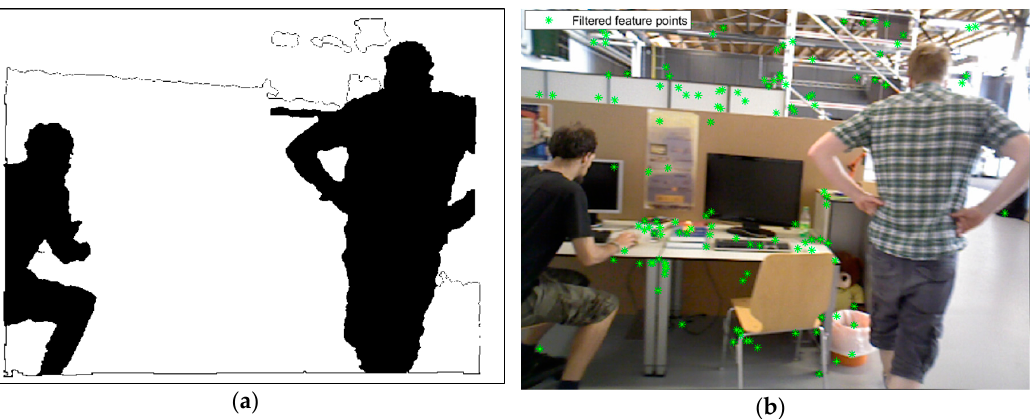
Figure 8. The final step of the moving object detection method. ( a ) The moving object judgement result of this example; ( b ) the remaining feature points on the current RGB image. The black areas in the binary image represent moving objects detected by our method. The star symbols in the RGB image represent the remaining feature points.